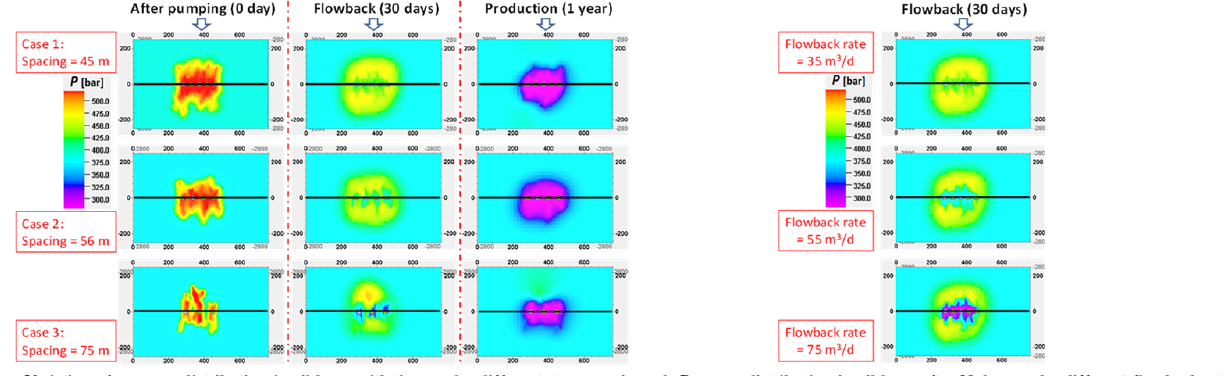
Figure 10. Variation of pressure distribution in oil layer: ( a ). stage spacing. ( b ). flowback rate.